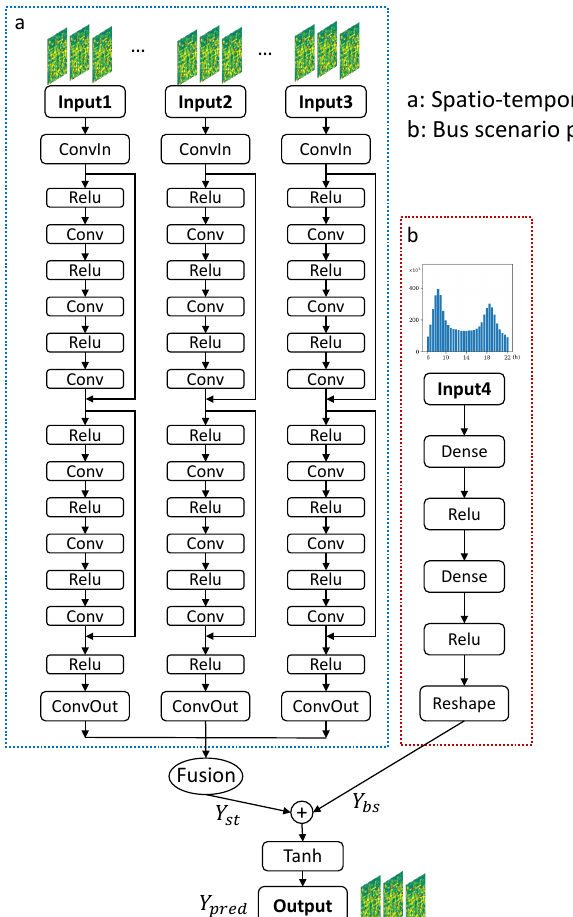
𝑌𝑌 𝑝𝑝𝑝𝑝𝑝𝑝𝑝𝑝 Figure 6. The architecture of improved deep residual